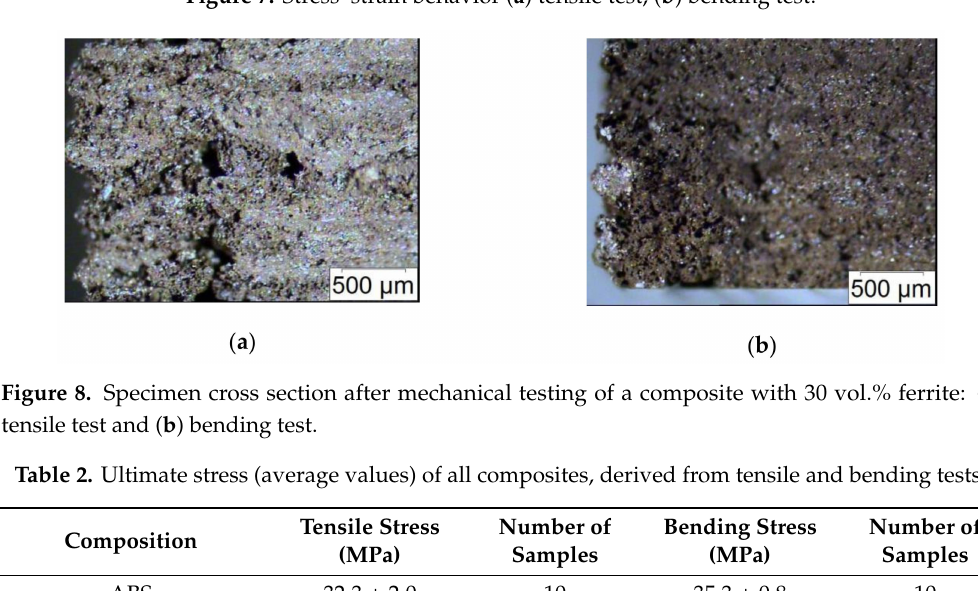
Figure 7. Stress–strain behavior ( a ) tensile test; ( b ) bending test.